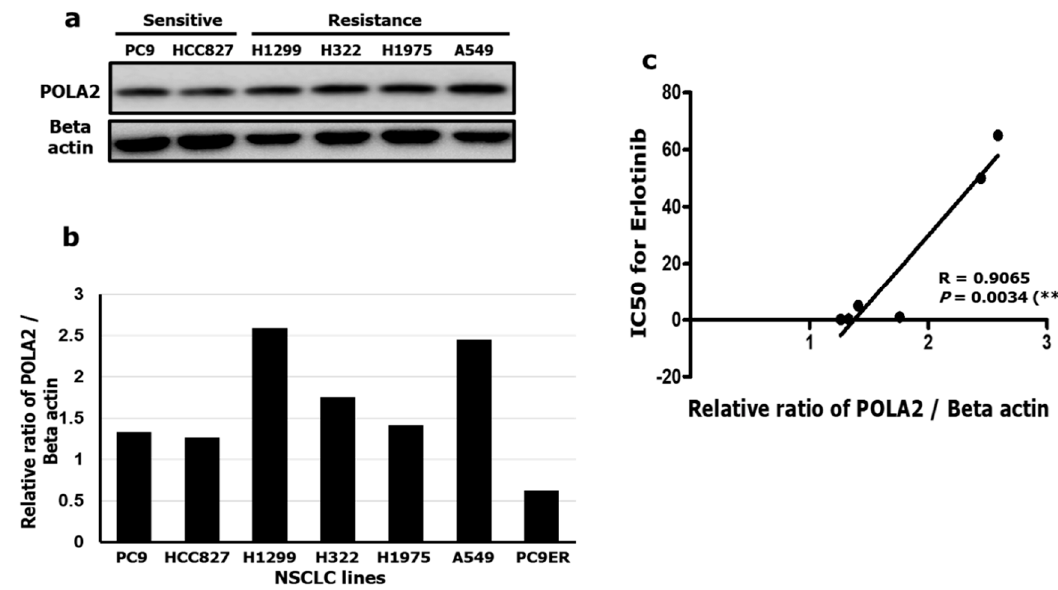
Figure 5. Erlotinib e ffi cacy is POLA2 level dependent. ( a , b ) POLA2 expression in Erlotinib-sensitive cell lines (PC9 and HCC827) and Erlotinib-resistant cell lines (H1299 and A549); ( c ) Pearson correlation graph between the IC 50 of Erlotinib and the relative ratio of POLA2 / beta actin in four cell lines tested. *** p < 0.001, ** p < 0.01, and * p < 0.05 versus control as determined by Student’s t - tests.